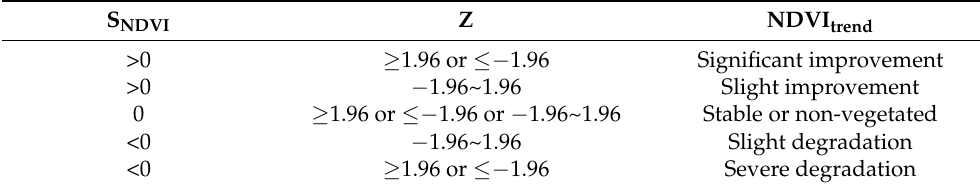
Table 2. Separation of the grades of vegetation variation